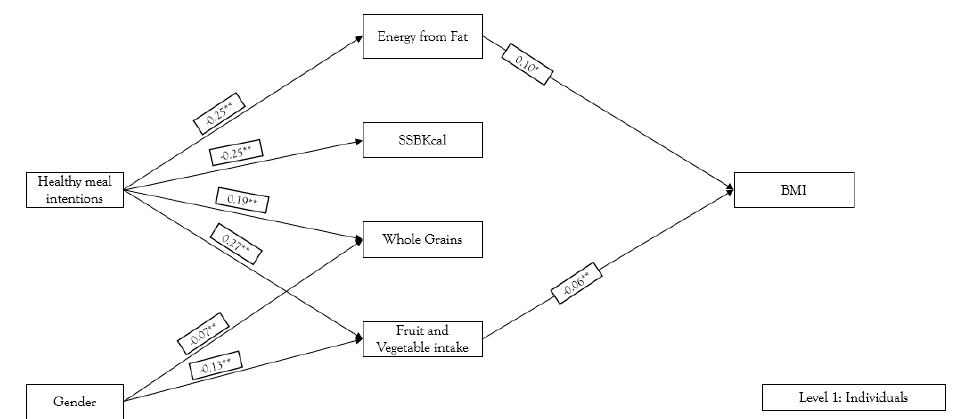
Figure 1. Multilevel structural equation modeling: Level 1—individual intentions/behaviors. * p <